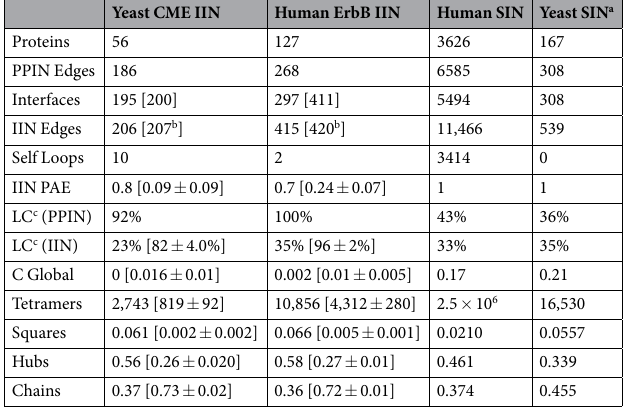
Table 1. Comparison of properties of the IINs from two manually curated PPINs and two automatically constructed IINs. Bracketed values are expected values for IIN properties with standard deviations, see Supplemental Text S2 and S4 for further details on calculations. a Only the cytoplasmic proteins used in (Deeds et al ., 2012). b Edges numbers were capped when sampling to prevent continuous growth. c Percent of nodes in largest component of